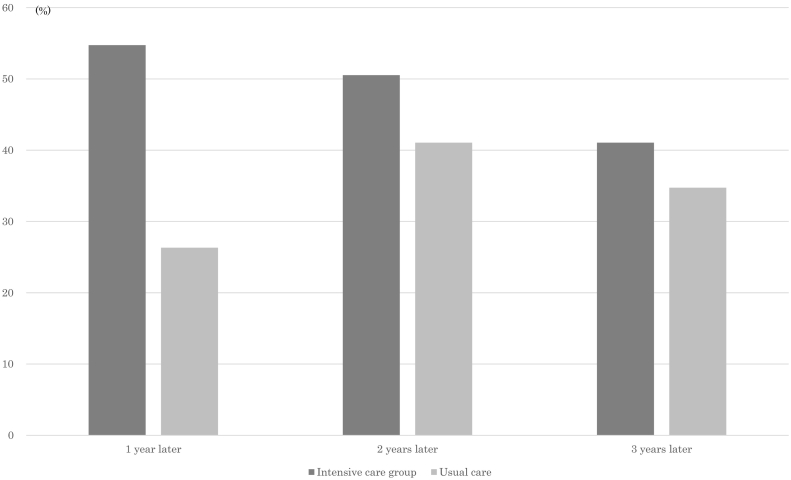
Proportions of the participants who achieved 3% reduction in body weight in 1–3 years in the propensity matched intensive care group and usual care group.